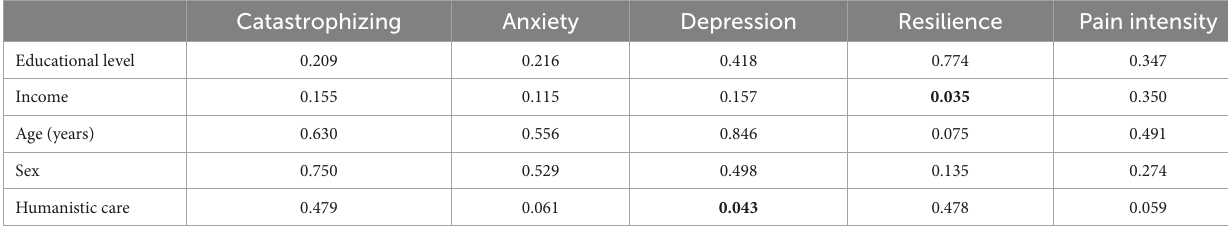
TABLE 2 The p -value of comparisons between categorical variables.